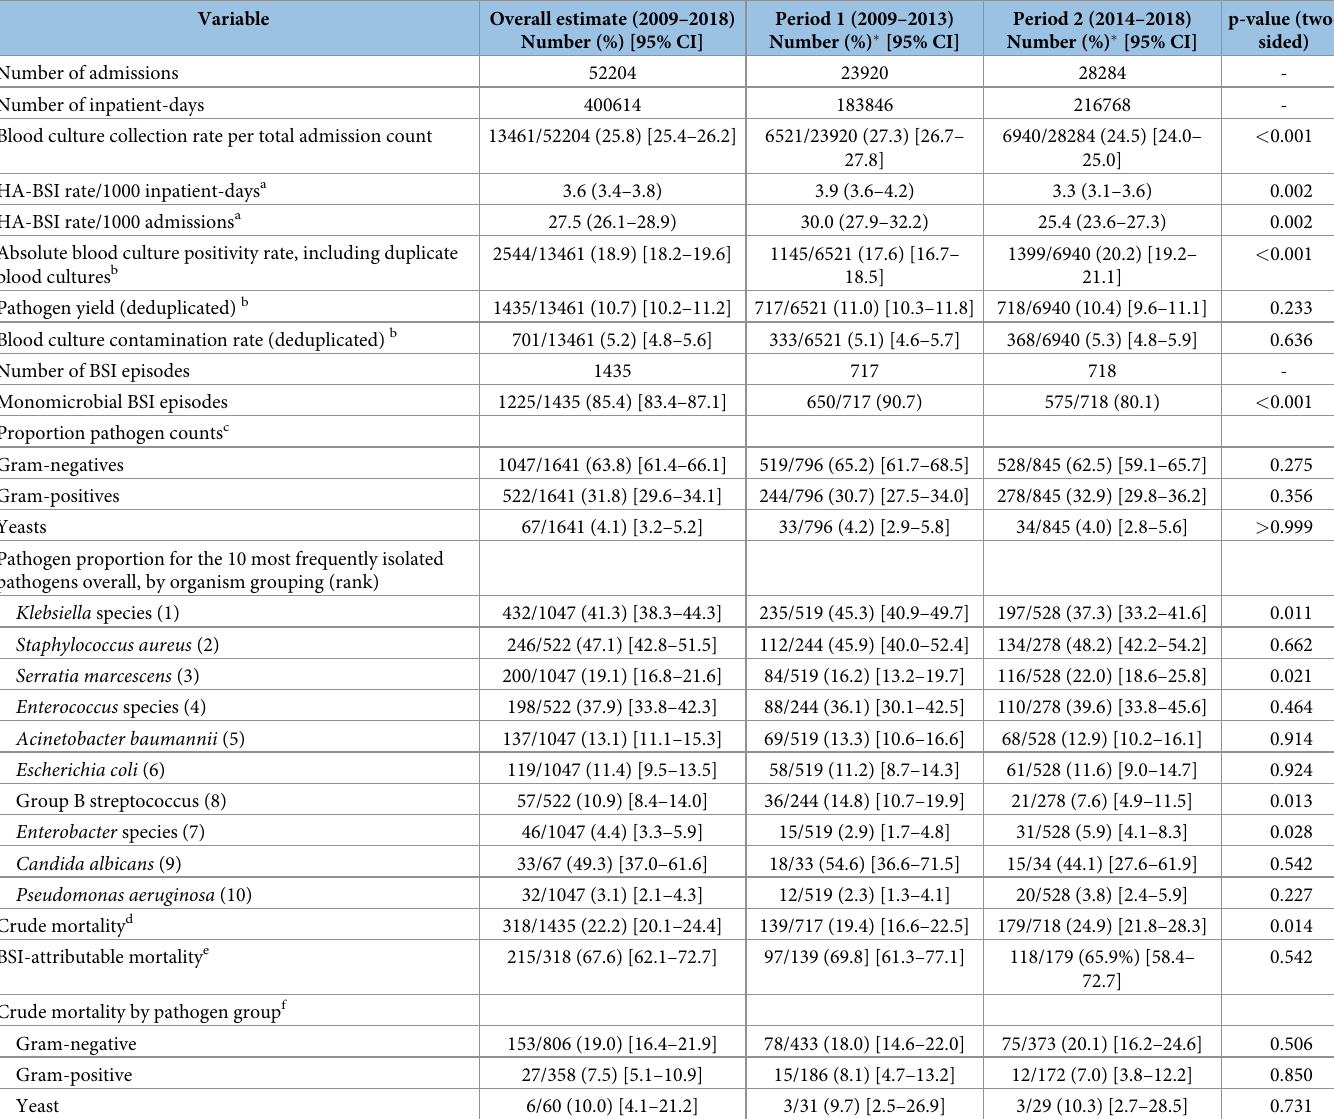
Table 1. Comparison of key variables in neonatal hospital-acquired bloodstream infection at Tygerberg Hospital from 2009–2018, and comparison between the Period 1 (2009–2013) and Period 2 (2014–2018).